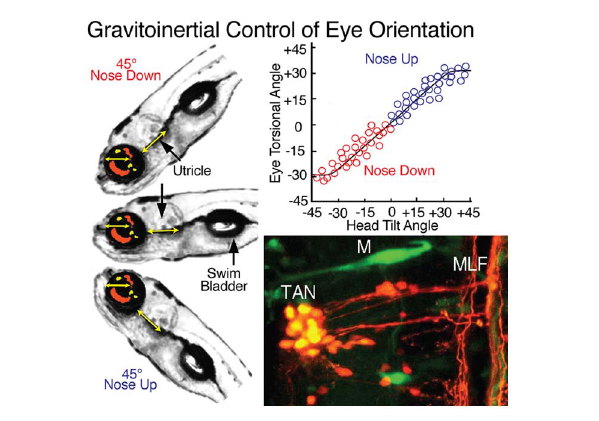
FIGURE 8 | Gravitoinertial control of eye orientation in larval zebrafish. Compensatory static eye positions attained during 45 ◦ nose up and − 45 ◦ nose down pitch are illustrated by the fish insets on the left. Precise counter-rotation of the eyes (top right) derived solely from sensorimotor transformation of utricular signals in tangential (TAN) neurons (bottom right). M, Mauthner cell; MLF, medial longitudinal fascicle. Figure summarizes results from Moorman etal. (1999); Suwa etal. (1999) and Bianco etal. (2012).